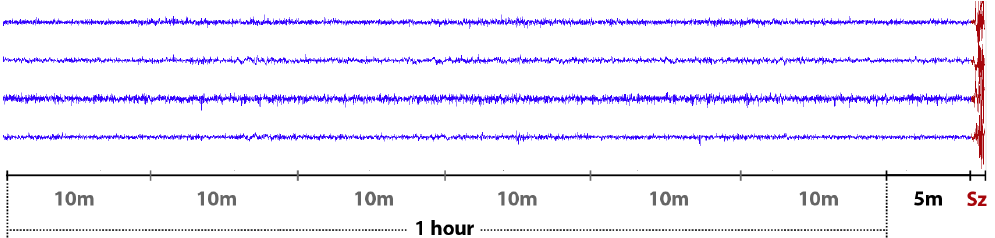
Figure 1. Examples of one-hour preictal (pre-seizure) EEG signals with a 5-min offset before seizures; Sz denotes the seizure onset. For convenience, only four channels are